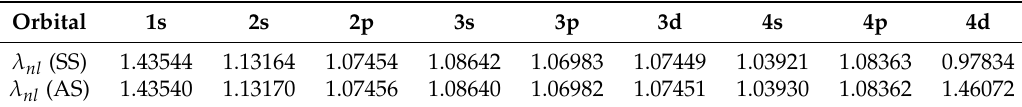
Table 1. Scaling parameters λ nl used in SUPERSTRUCTURE and AUTOSTRUCTURE atomic structure